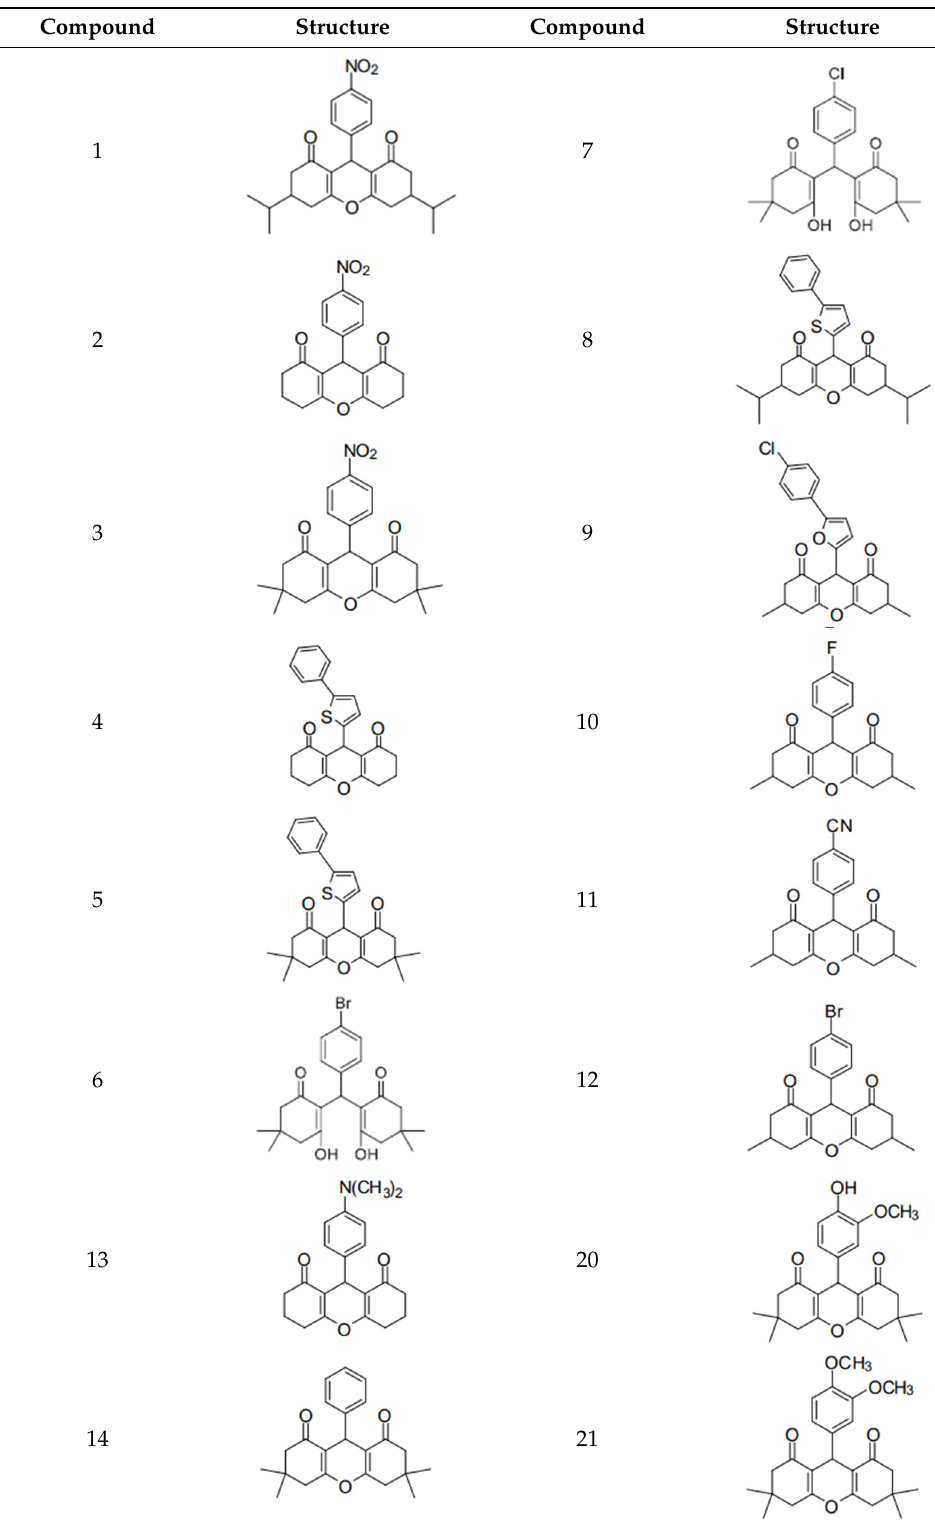
Table 1. Chemical structures of cyclic ketones.